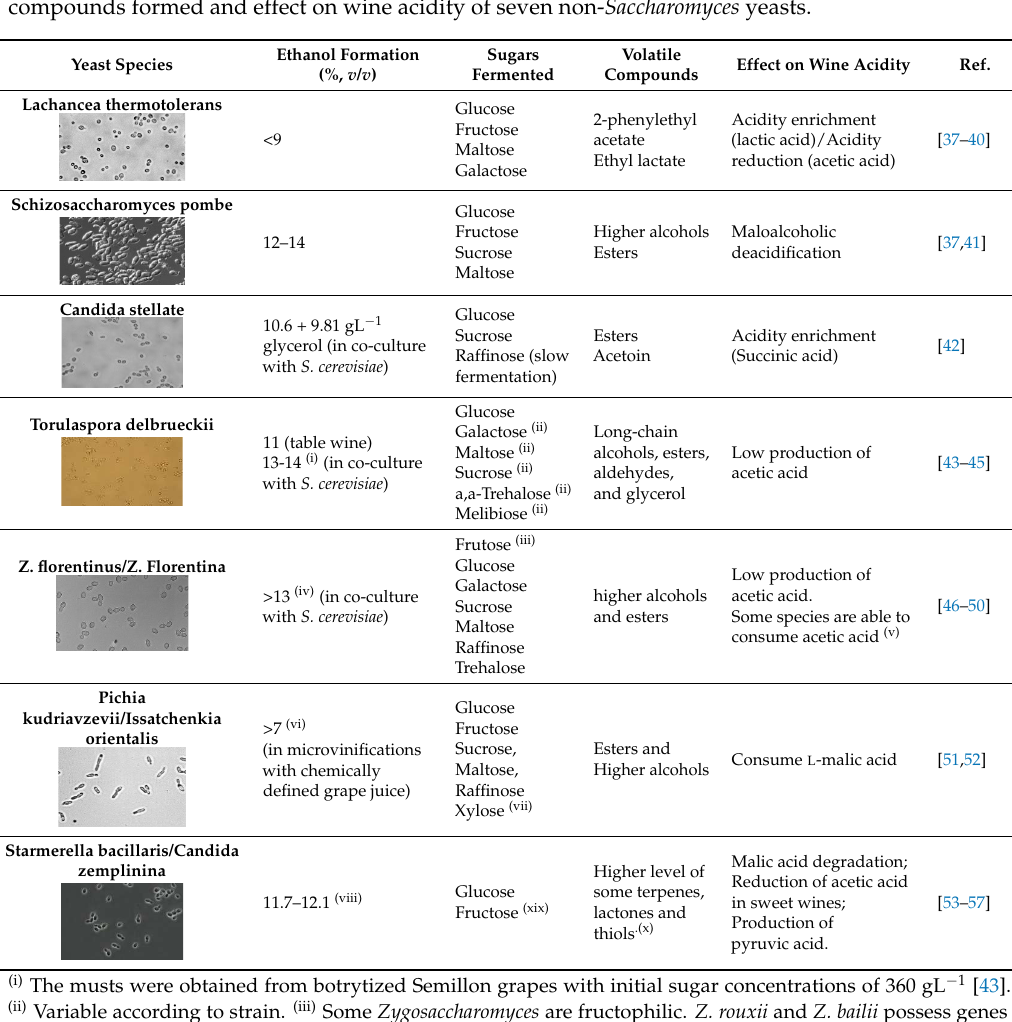
Table 2. Percentage of ethanol formed during fermentation, sugars fermented, main volatile compounds formed and effect on wine acidity of seven non- Saccharomyces yeasts. Yeast Species